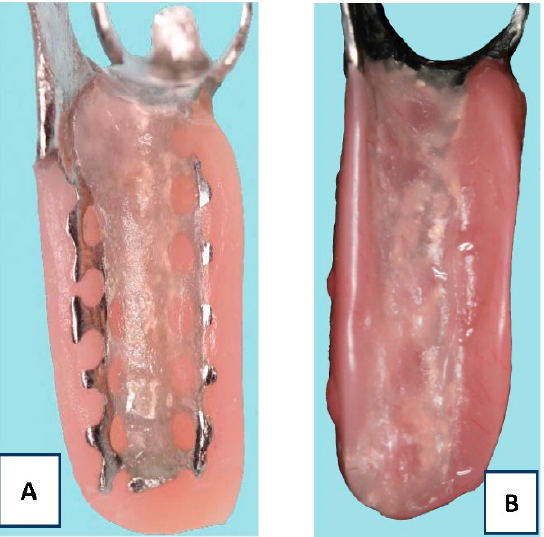
Figure 6. Mandibular RPD denture bases. ( A ) Old RPD with metal framework exposure. ( B ) Newly fabricated RPD with proper denture base extension and acrylic thickness.